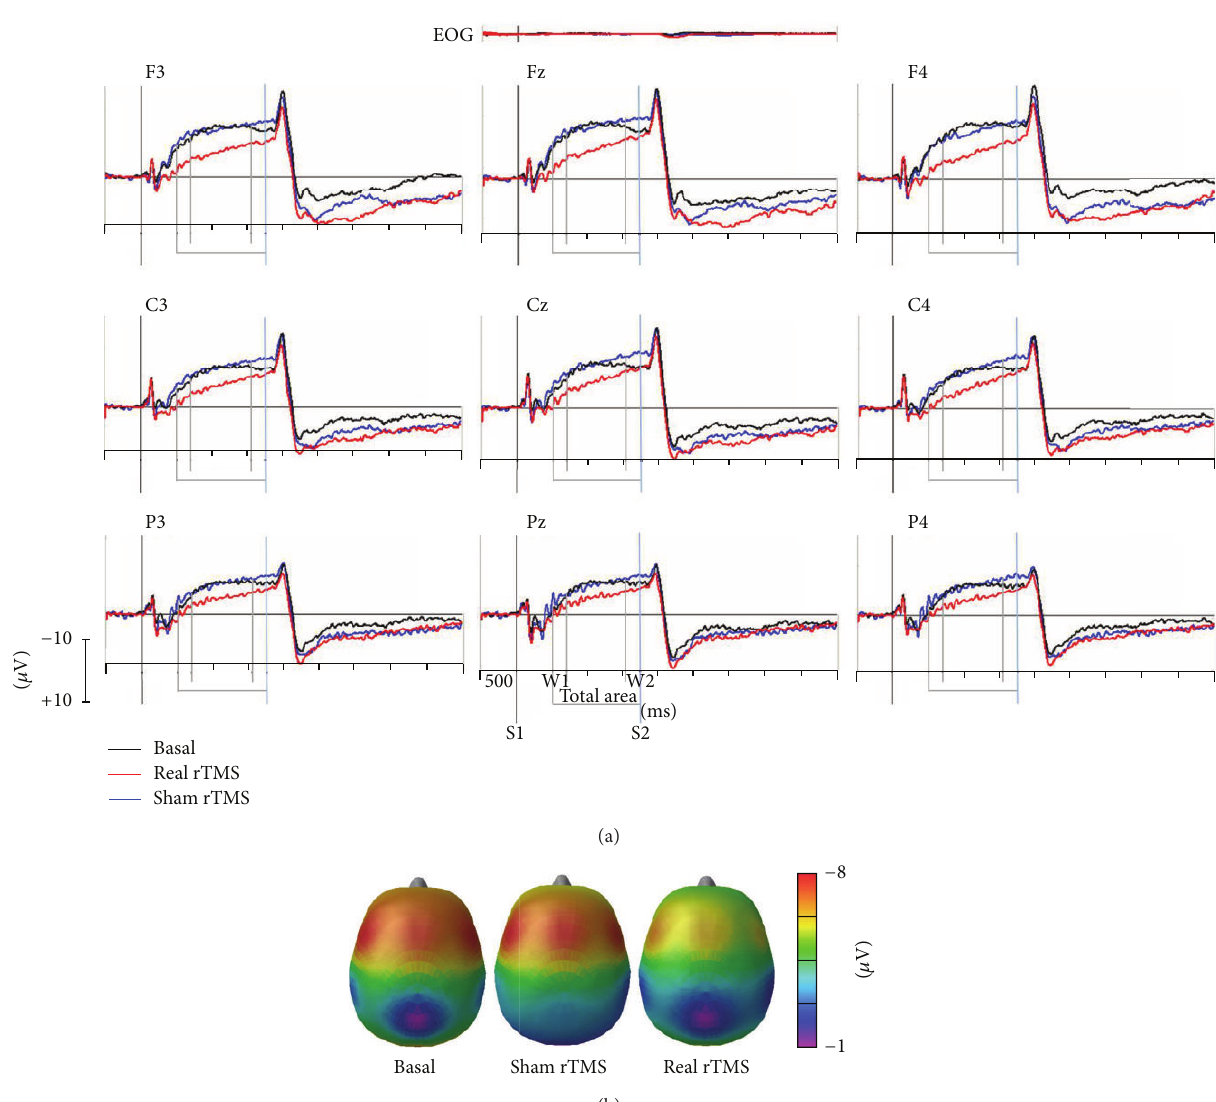
Figure 1: (a) Grand averaged CNV waveforms, with W1, W2, and total areas highlighted and superimposed at basal condition (black lines), post-real rTMS (red lines), and post-sham rTMS (blue lines) collapsed for condition for all subjects. S1: warning stimulus (flash). S2: imperative stimulus (tone; standard: 1000Hz, target: 2000 Hz). (b) Scalp potential maps at 600ms (mean value of W1-CNV) for basal condition, post-sham rTMS and post-real